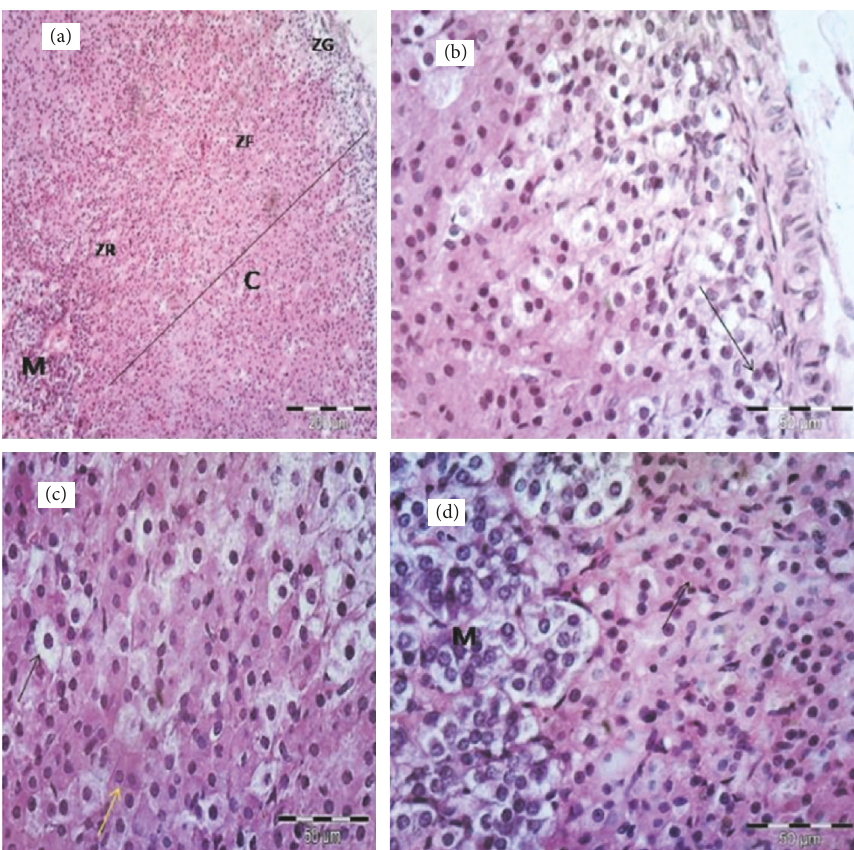
Figure1:Photomicrographsoftheadrenalglandofthecontrolgroupshowing(a)adrenalcortex(C),zonaglomerulosa(ZG),zonafasciculata (ZF), zona reticularis (ZR), and adrenal medulla (M) × 100. (b) A higher magnification of ZG cells arranged in oval or rounded clusters and with deeply stained nuclei (arrow), × 400. (c) A higher magnification of ZF cells showing highly vacuolated cells (black arrow) and less vacuolated cells with acidophilic cytoplasm (yellow arrow) and vesicular nuclei, × 400. (d) A higher magnification of ZR showing small cells with deeply acidophilic cytoplasm (arrow); M, medulla, ×